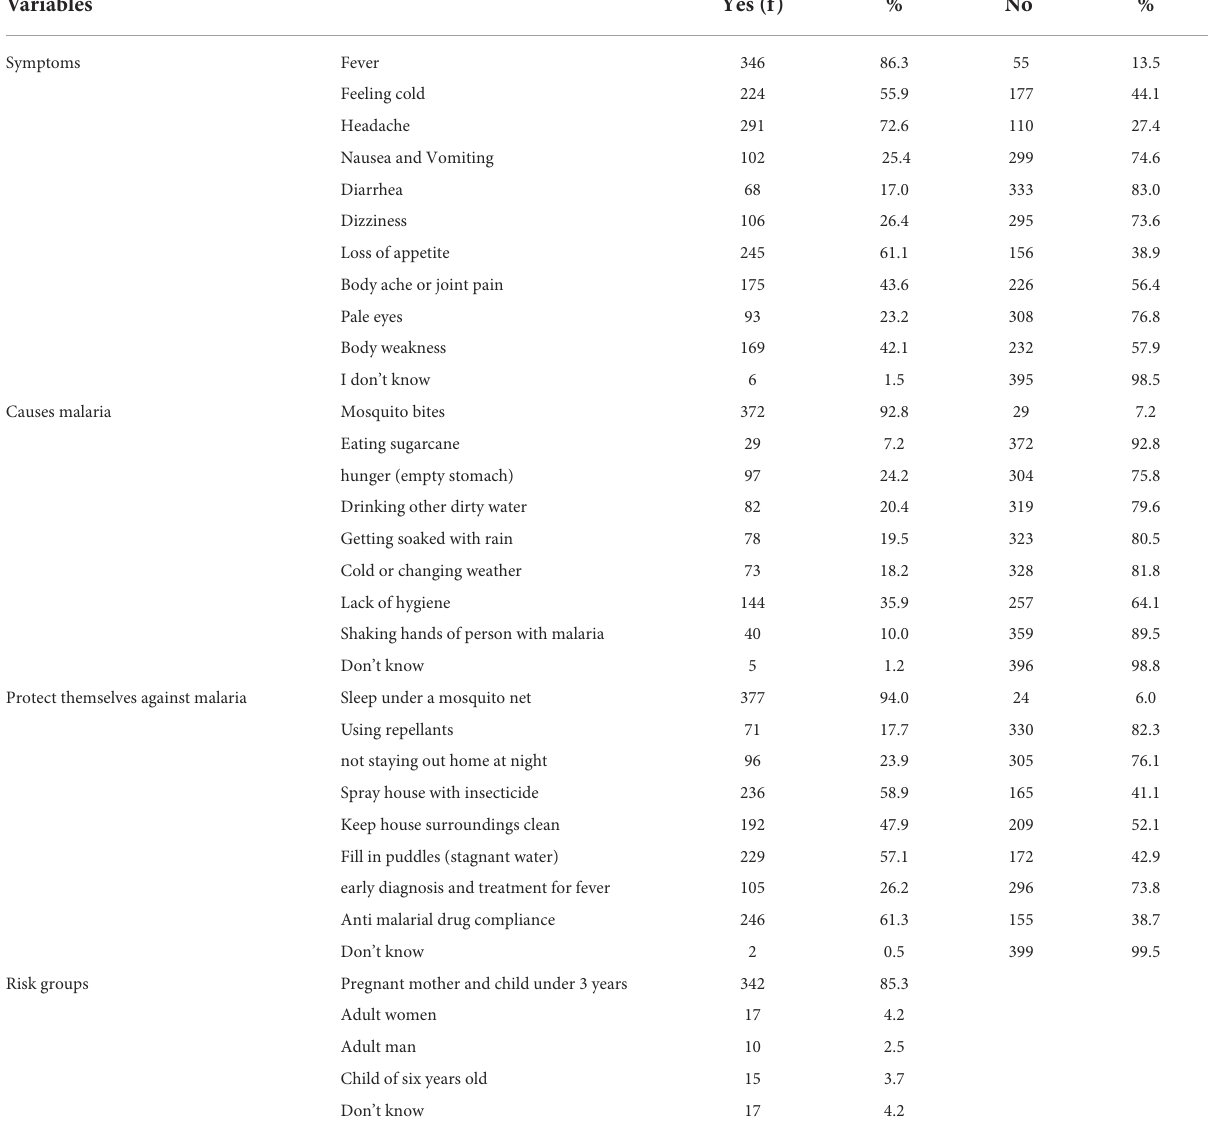
TABLE 2 Frequency of the respondents’ knowledge about malaria signs and symptoms, risks of transmission, and prevention methods in Jimma zone, south west, Ethiopia, 2020. Variables